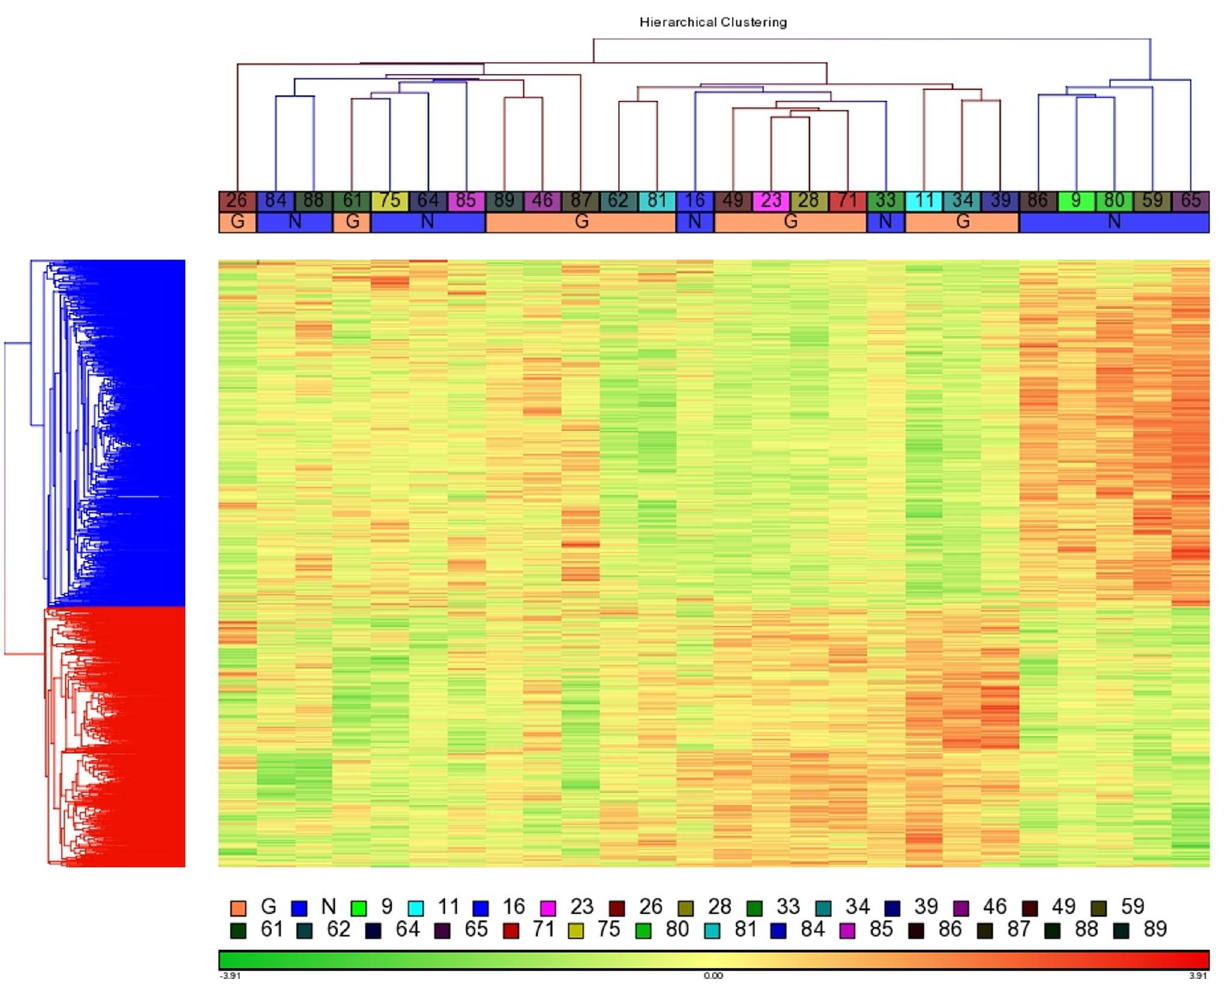
Figure 2. Hierarchical clustering of 1936 genes across 26 kidney transplant recipients. Heatmap representation of expression values for genes (rows) across recipients (columns), whereby low expression is denoted by green and high expression by red. The expression of each gene was normalized across all samples. Recipients were categorized into weight gainers (G, peach color) or non-gainers (G, blue color) if their net weight change was greater or less than 5%, respectively, at 6 months post-transplantation.